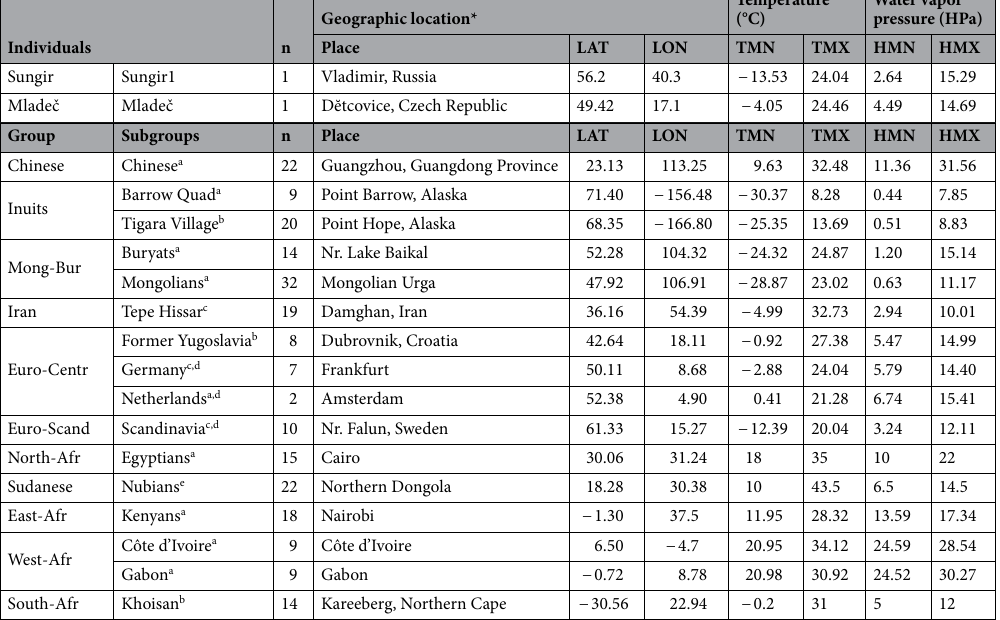
Table 1. Groups and individuals in the study. LAT Latitude, LON Longitude, TMN Average minimum annual temperature of the coldest month, TMX Average maximum annual temperature of the hottest month, HMN Average minimum annual water pressure, HMX Average maximum annual water pressure. *Location coordinates are transferred into a decimal system. a Smithsonian Institute, Washington DC. b American Museum of Natural History, New York City, NY. c University of Pennsylvania Museum of Archeology and Anthropology, Philadelphia through the Open Research Scan Archive. d University of Leipzig Anatomical Collection, through NESPOS. e Kulubnarti Collection, University of Colorado Boulder,